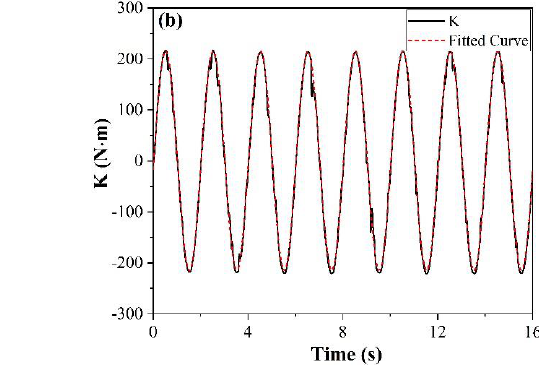
Figure 12. Simulation results of harmonic sway fitted by MATLAB: ( a ) transverse force; ( b ) roll moment. Table 2. Dimensionless hydrodynamic coefficient of HG1.